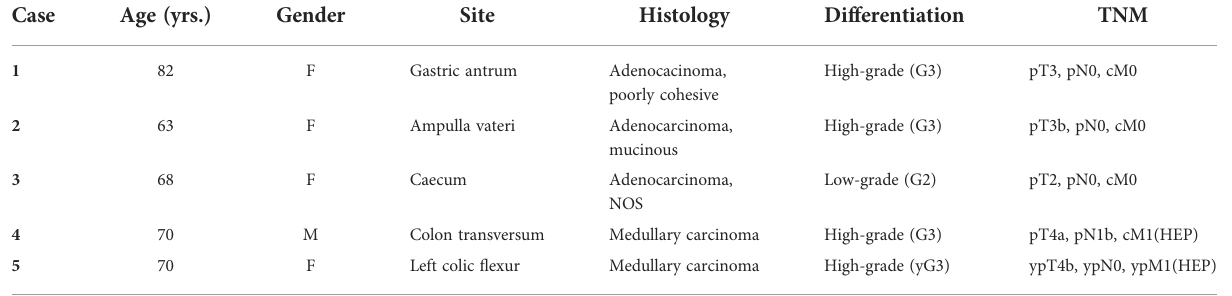
TABLE 1 Clinicopathological features MLH1 - /PMS2 - /MSH6- digestive system cancer cases. Case